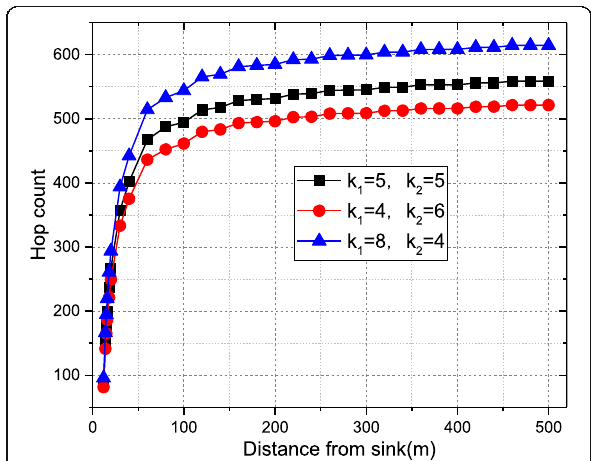
Fig. 17 Number of detection hops that created by the remaining energy( r =